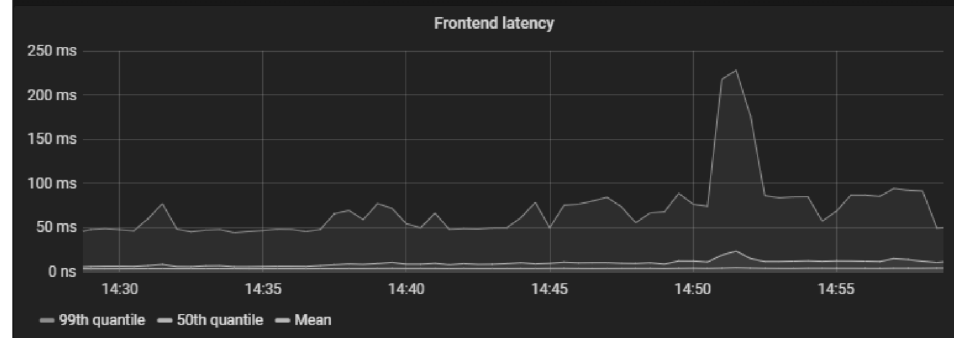
Figure 12. Front-end latency after CPU fault injection.